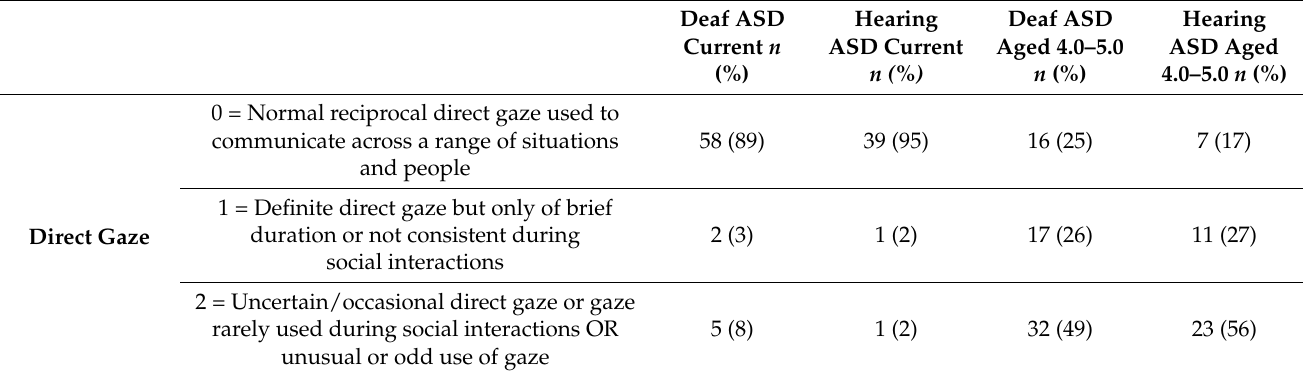
Table 4. Differences in direct gaze and social